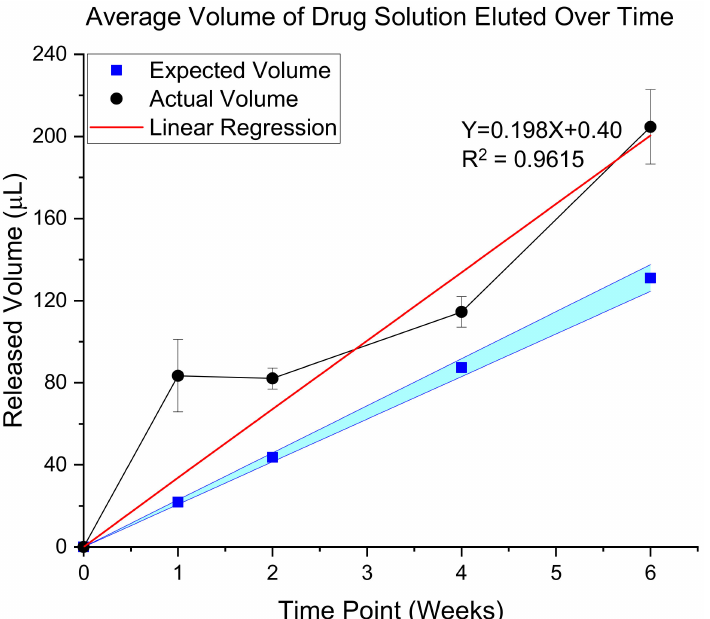
Figure 7. Validation of In Vivo Delivery Rate. The predicted flow rate (black line, circle markers) for osmotic pumps is plotted with the actual flow rate (blue squares in cyan band) for N = 4 animals. A linear equation was fit to the measured data (red line), showing that the actual flow rate was 19.8 µ L/h with an R2 value of 0.9615. The expected flow rate is 13 µ L/h, plotted with a +/ − 5% band, the expected acceptable error of the osmotic pump flow